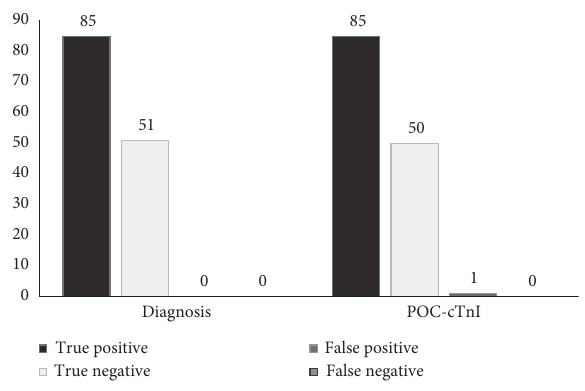
Figure 2: Test performance of 0 and 3hour instant-view POC-cTnI qualitative assay for diagnosis of AMI according to the serial hs- cTnI assays.